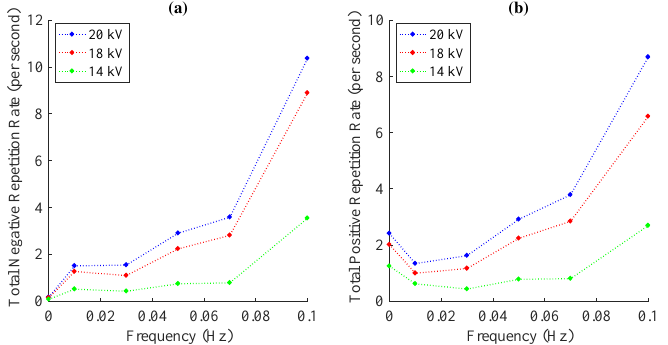
Figure 12. Frequency dependence of total PD repetition rate for ( a ) negative rate; ( b ) positive